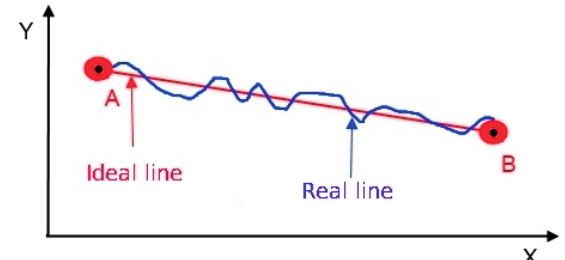
Figure 3. Configuration for measuring errors between the ideal and actual